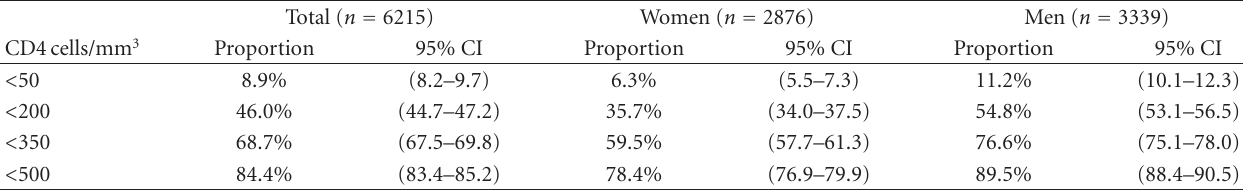
Table 3: Proportions and Wilson 95% confidence intervals for four di ff erent CD4 cell count thresholds at HIV